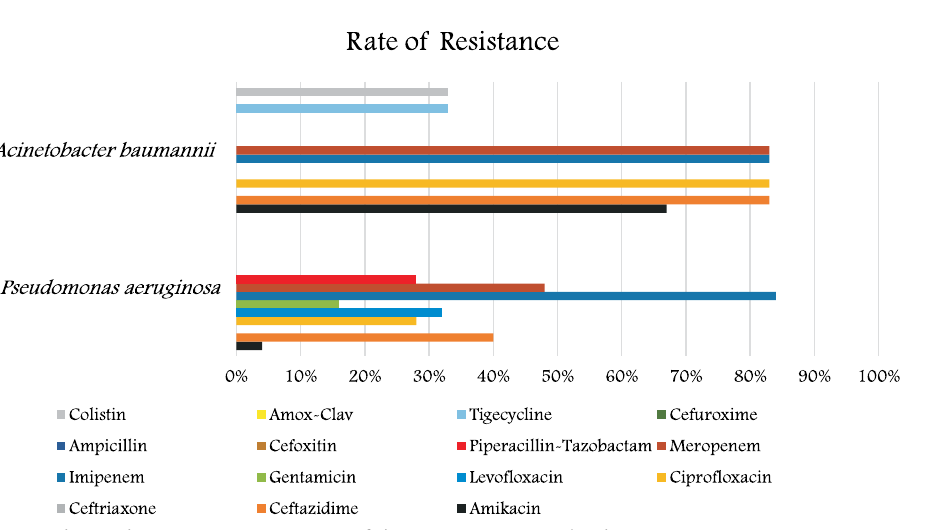
Fig. 3. The antibiotic resistance pattern of the P. aeruginosa and A. baumannii. Table 2. A number of ESBL and MBL producing bacteria detected by phenotypic